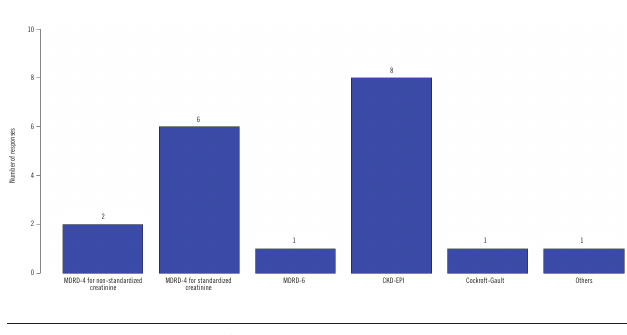
Figure 3 − eGFR measuring formulas eGFR: estimated glomerular filtration rate; MDRD-4: Modification of Diet in Renal Disease version 4; MDRD-6: Modification of Diet in Renal Disease version 6; CKD-EPI: chronic kidney disease-epidemiology collaboration.